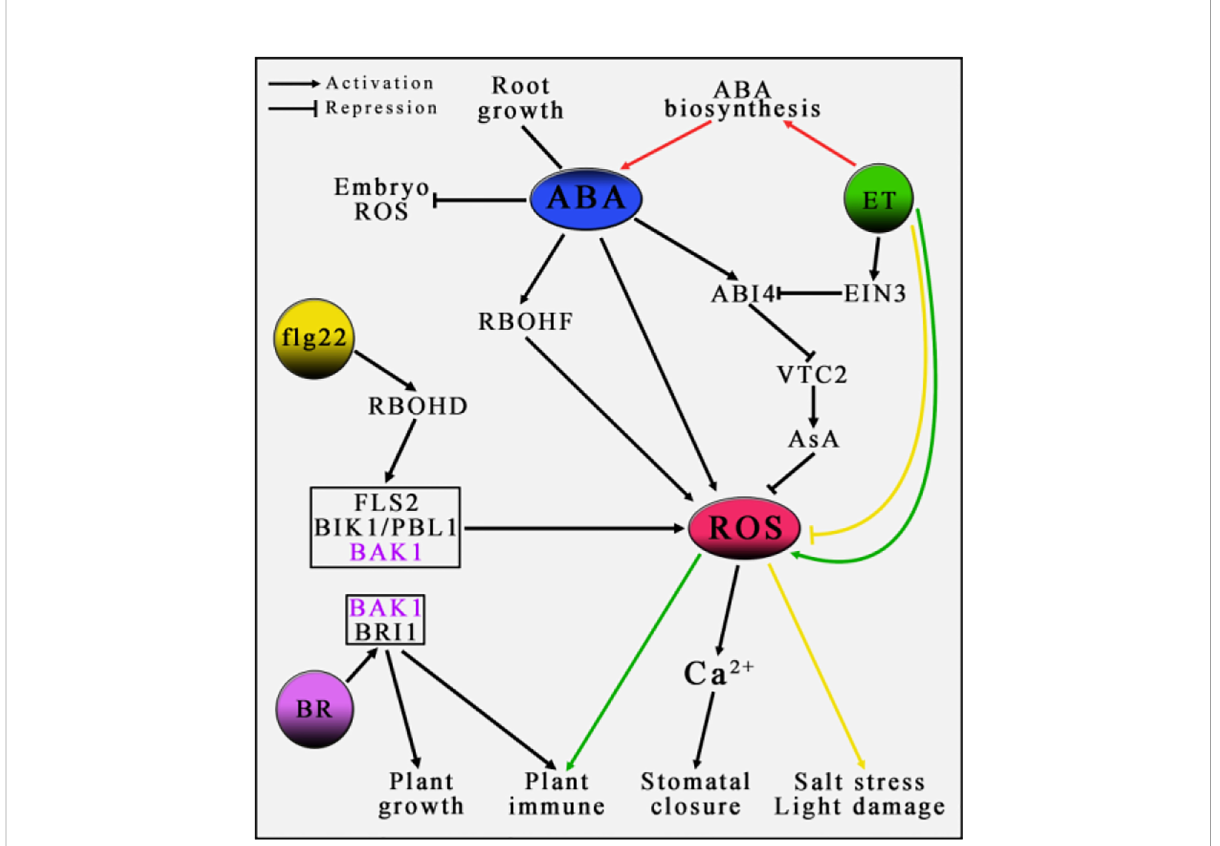
FIGURE 2 The role of ROS in the regulation of plant by hormones. In the process of plant growth and development, plant hormones play an important regulatory role, such as ABA, ET, BR, etc. In the entire regulatory network, ROS may play a central pivotal role. It remains to be elucidated whether BAK1, as an important element in the pathway of ROS generation induced by fl g22, is the key site associated with the BR signaling pathway. Lines of the same color indicate the same regulatory pathway. For detailed explanation, please see